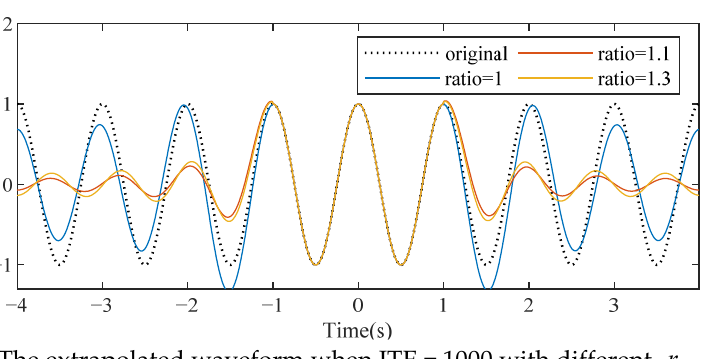
r . ( b ) The extrapolated waveform when ITE = 1000 with different / f s Figure 2. The waveform comparison between original signal and extrapolated signals ( α = 0.25). In Figure 1, all MSEs decrease with more iterations, reflecting a more accurate extrapo- lation. With the same r f / s , the MSE is smaller when the truncated rate is larger. However, the MSE bottleneck appears during each extrapolation, especially when r f / s = 1. For all truncated rate with r f / s = 1, the bottleneck appears within 400 iterations and appears earlier with larger truncated rate. According to the theory of GP algorithm, it is attributed to the very small eigenvalue extrapolated with large iterations cannot improve the accuracy obviously though the whole extrapolation is convergent [18]. With the same truncated rate α , the best extrapolation presents with r f / s = 1, and MSE performance deteriorates with larger ratio. Especially with small α ( α = 0.25), the MSEs at r f / s = 1.1 and r f / s = 1.3 turn larger by 120% compared with r f / s = 1. Besides, the MSE improvement from r f / s = 1.3 to = 1.1 is slight, reflecting the extrapolation accuracy is difficult to improve by adjusting r f / s the extrapolation filter unless it is optimal ( r f / s = 1). Considering the influence of finite duration on the signal bandwidth, it can be inferred that the optimal ratio is not 1 for some other signals. In that case, an extrapolation convergence bottleneck should be solved and the extrapolation at large iteration filter bandwidth needs to be improved. For a fair comparison, the MSE reflects the difference at the extrapolated location and is normalized, defined